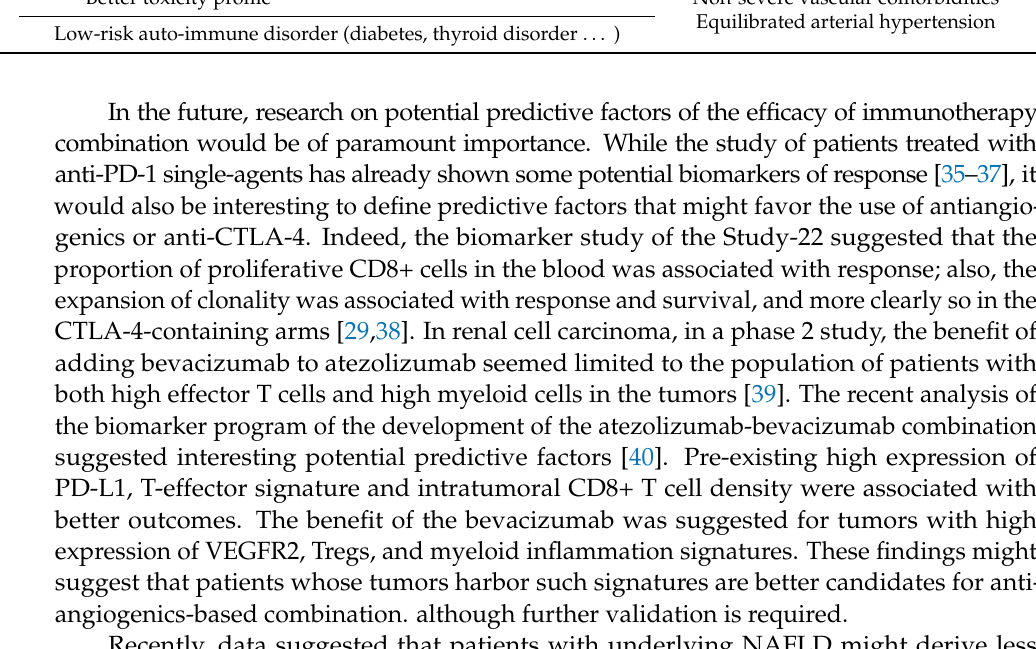
Anti-CTLA-4-Based Severe vascular comorbidities Significant Portal